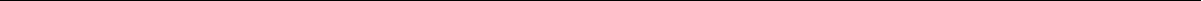
Fig. 5 RNA-seq after miRNA cocktail exposures shows myogenic-speci fi c comittment enhancement of transcriptional pro fi le. a PC analysis of a MAB-MiPs samples reveals stage-speci fi c, progeny-speci fi c clustering. b Unbiased clustering of MAB-MiPs analyzed by RNA-seq. c – f Volcano plots of fold change vs p -value of all DE genes in different conditions (threshold, P = 0.05, dashed line). MAB-MiPs untreated vs MAB-MiPs+AMC c , MAB-MiPs untreated vs MAB-MiPs+PMC d , fi broblast-MiPs untreated vs fi broblasts-MiPs+AMC e , fi broblast-MiPs untreated vs fi broblasts-MiPs+PMC f . Left side of all charts, all genes and highlighted candidates enriched in untreated-MiPs; right side, genes and candidates enriched in treated-MiPs. Blue dots depict genes that were found downregulated while red dots depict genes that were found upregulated upon treatments. g Quantitation of results obtained from bisul fi te sequencing of upstream CpG islands of selected anti-myogenic and pro-myogenic gene pools in treated and untreated cells. Data is depicted as heatmap of average percentages of methylated CpGs. h Quantitation of results obtained from ChIP-qPCR experiments analyzing fi broblast- and MAB-MiPs treated and untreated. H3k9me3, repressive marker; H3k4me2, H3k27ac, permissive markers. Data is depicted as heatmap of average percentages of IP-enriched vs total input DNA ( n = 3). f-, fi broblast-derived. AMC, anti-myogenic cocktail (miRNA-based), PMC, pro-myogenic cocktail